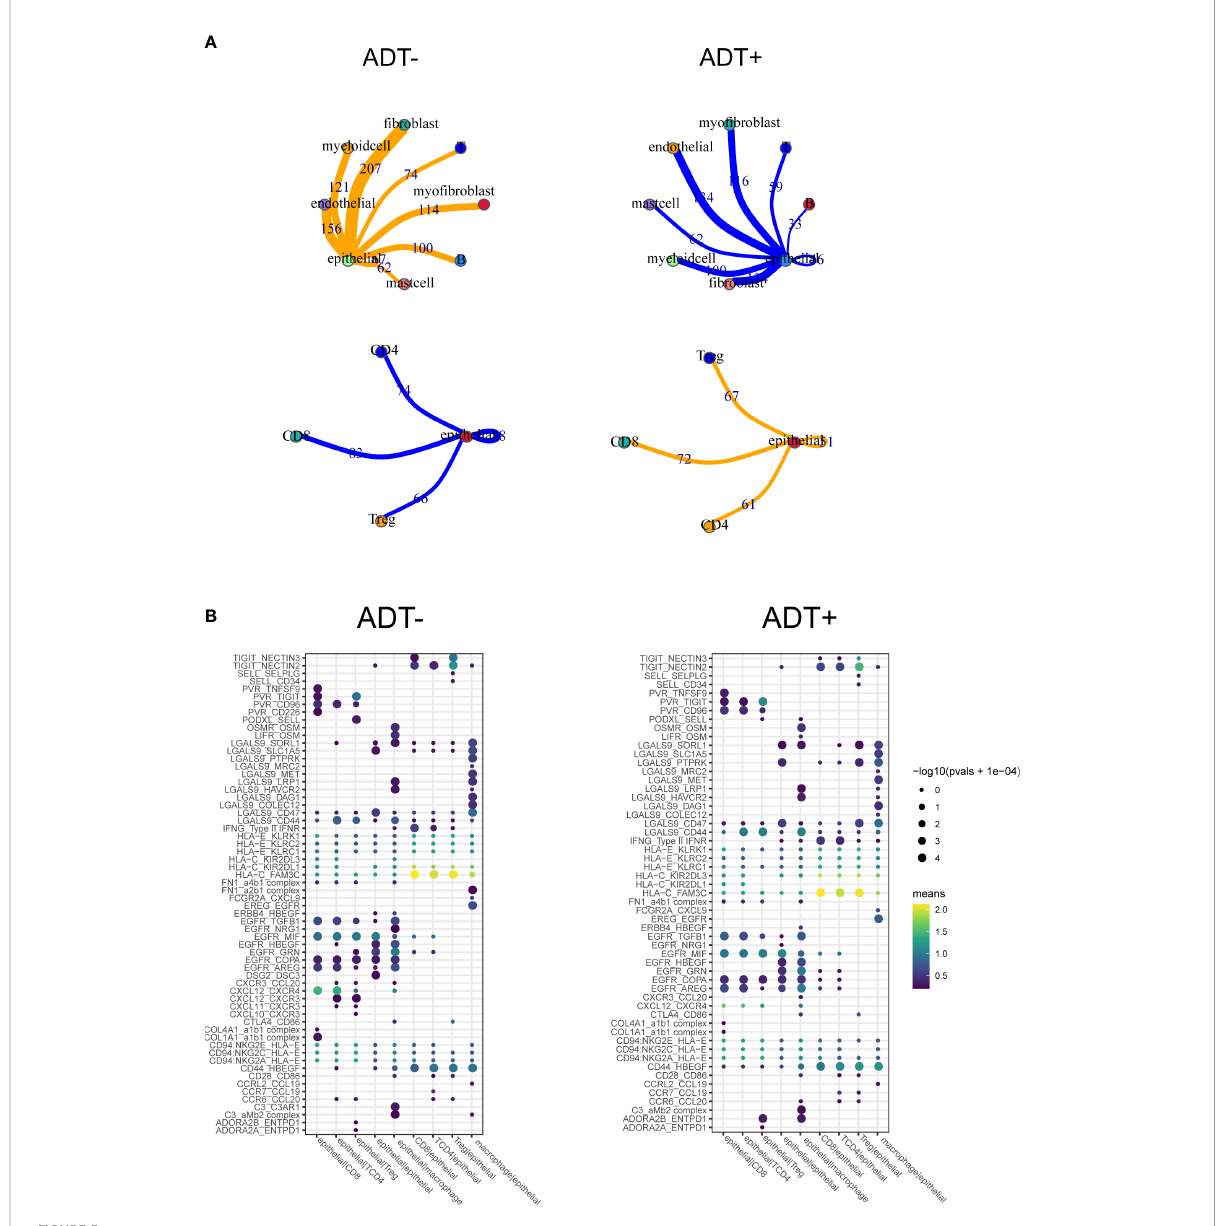
FIGURE 5 Composition and cell-cell interactions of the prostate cancer microenvironment. (A) View of the ligands expressed by epithelial cell and the other cells expressing the cognate receptors primed to receive the signal. Numbers indicate the quantity of ligand – receptor pairs for each intercellular link. (B) Summary of selected ligand-receptor interactions between epithelial cell and the other cell types. P-values (permutation test) are represented by the size of each circle. The color gradient indicates the level of